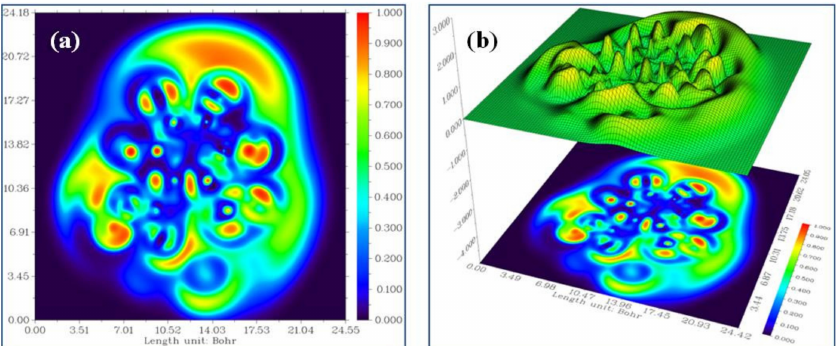
Figure 5. ( a ) ELF color filled map. ( b ) Shaded surface map with projection effect of the hydrogen bonding region in